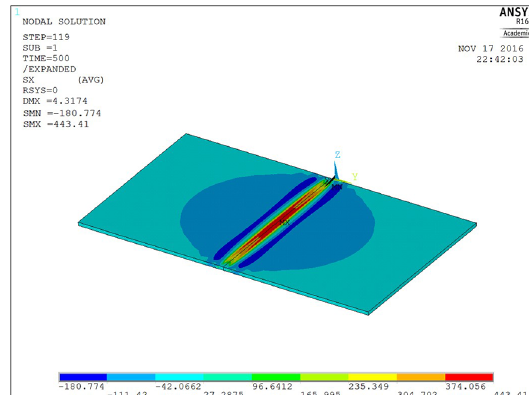
Figure 9. Temperature distribution during welding process for four different time steps 1.5 s (b) 9.5 s (c) 12 s and (d) 23.5 s.